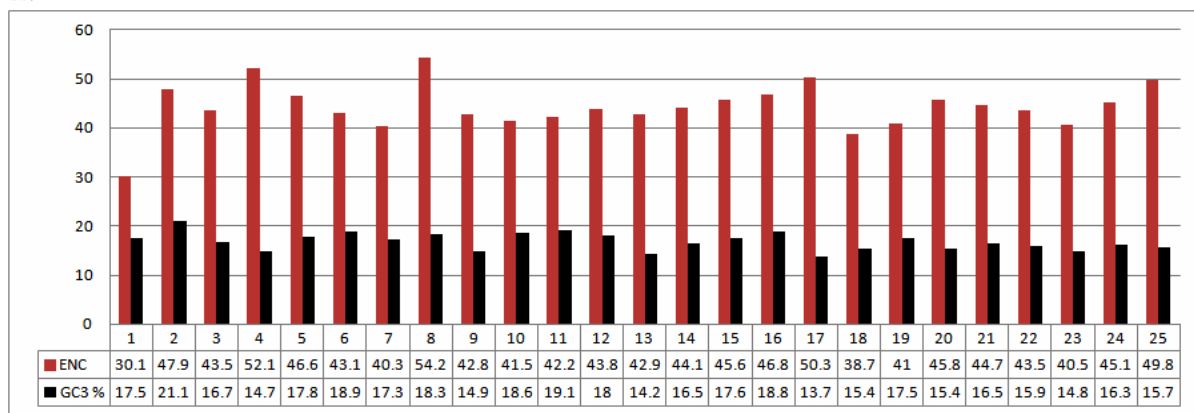
Fig. 2. Frequency of GC3s and the distribution of ENC values of 25 selected coding sequences